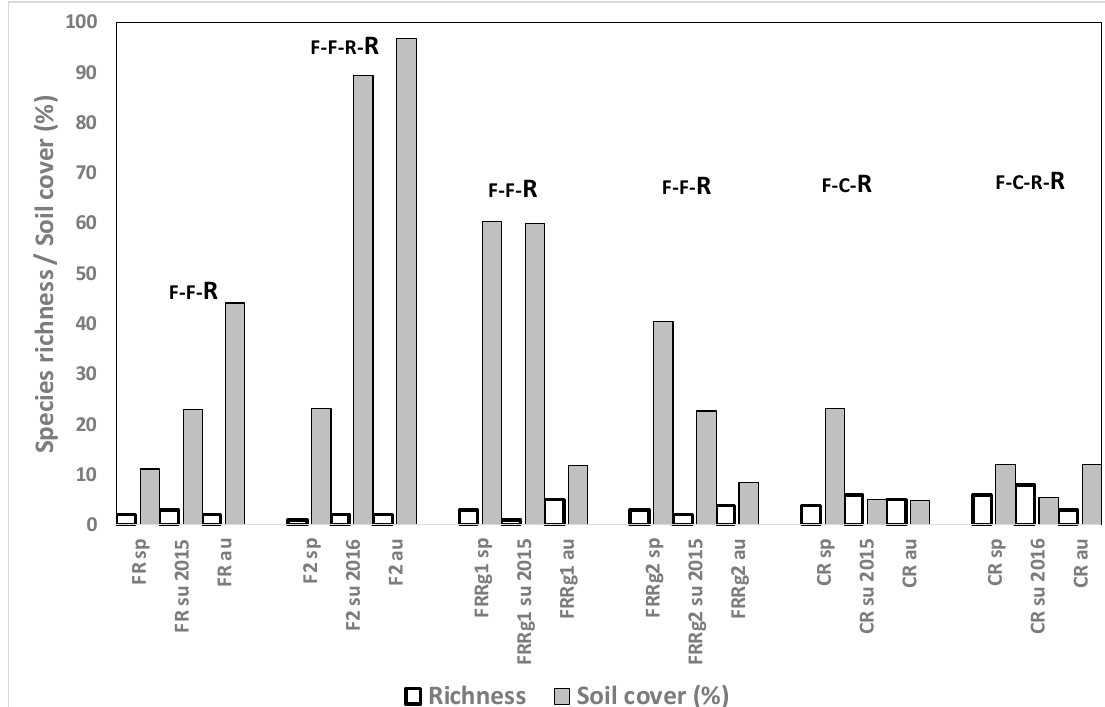
Figure 9. Species richness and total weed soil cover (%) for the fields where rice is grown after other crops in spring, summer and autumn 2014, 2015 and 2016. The sampled crop is the last of the crop rotation.